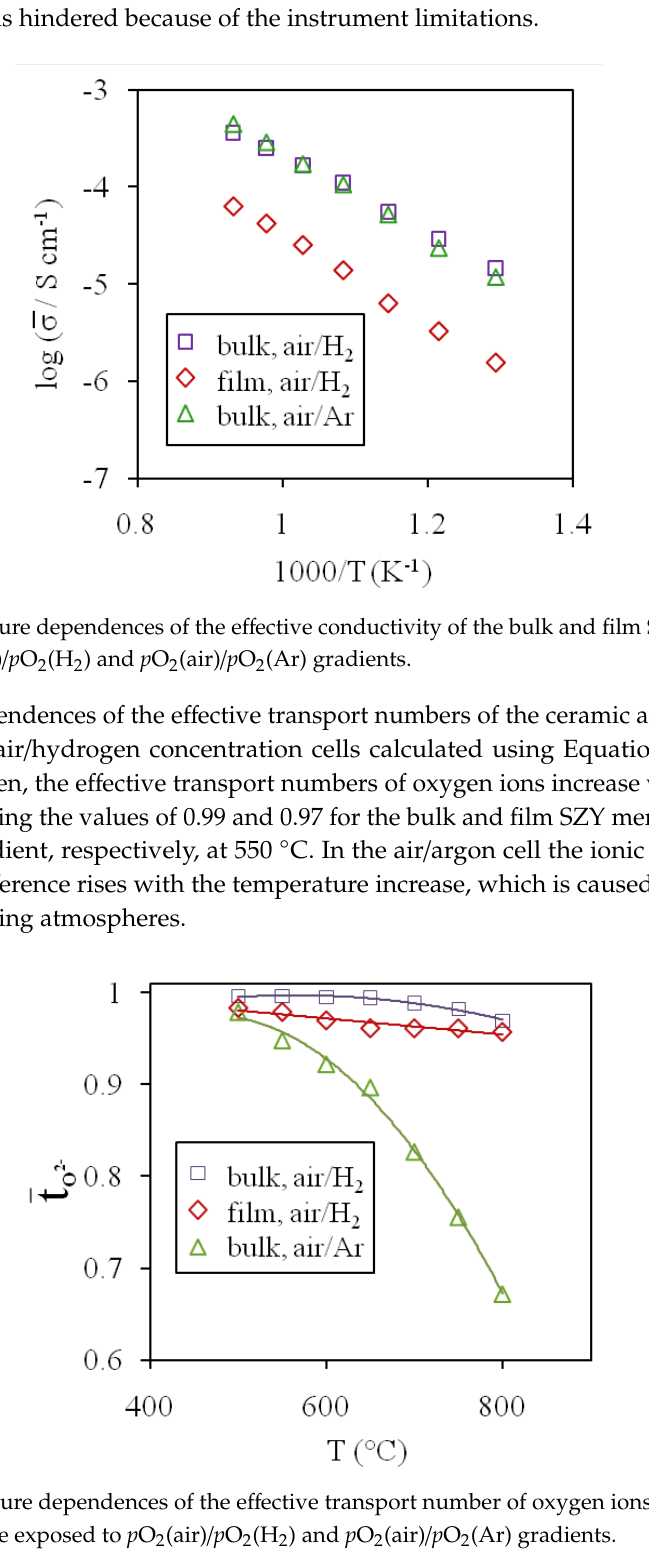
film SZY membrane exposed to p O 2 (air)/ p O 2 (H 2 ) and p O 2 (air)/ p O 2 (Ar) gradients.